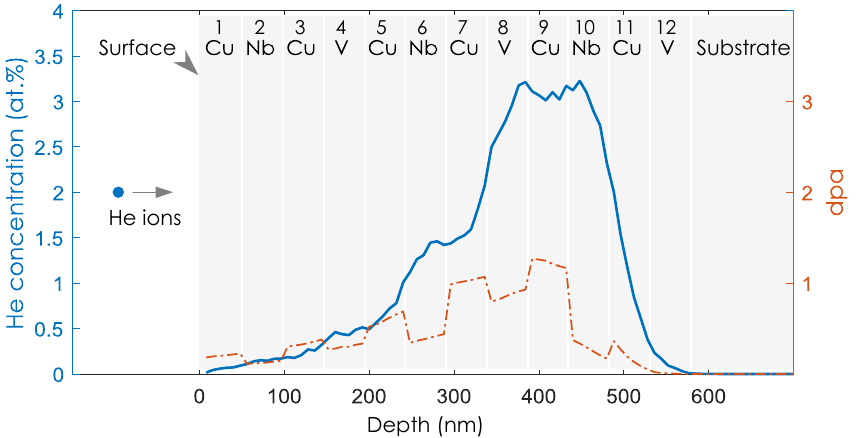
Figure 1. The depth distribution of helium concentration and dpa distribution in Cu-Nb-Cu-V 48 nm NMMCs simulated by SRIM. The helium ions are injected perpendicularly to the surface layer which is made of Cu and numbered as the 1st layer. The NMMCs are repeated of Cu-Nb-Cu-V periodically and the bottom layer is numbered as the 12th layer. The energy of the incident helium ions is 119 keV, and the total dose is 6 × 10 16 ions/cm 2 .